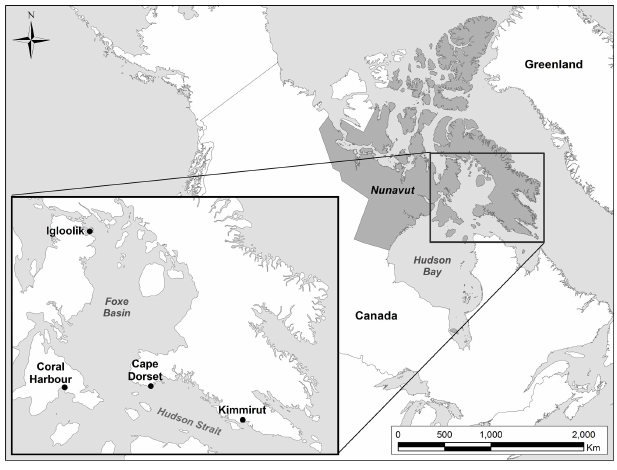
Fig. 2 . Map of the study area and location of the four surveyed